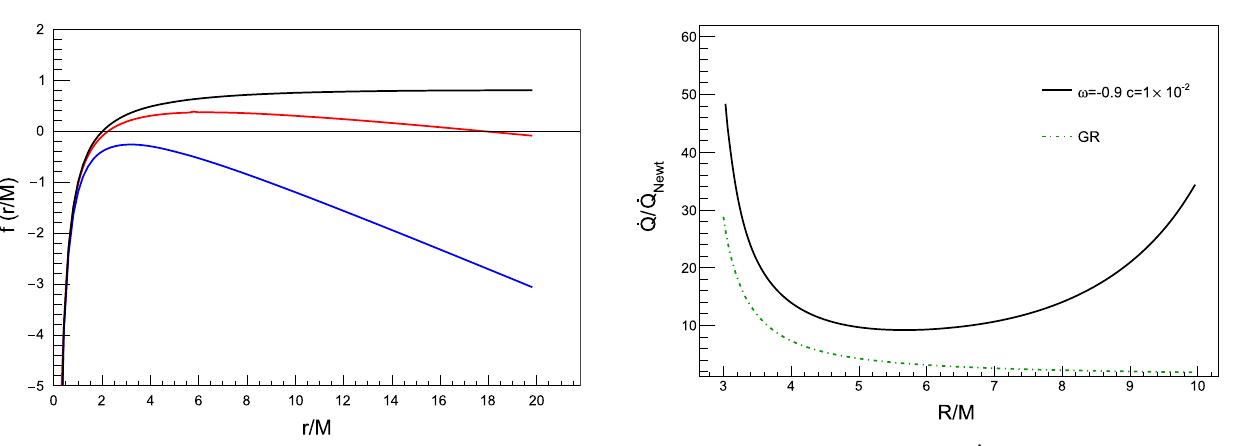
Fig. 1 The f ( r ) function defined in (2) vs r / M , The parameters ω q and c are fixed as ω q = − 2 / 3, c = 0 . 01 (black), c = 0 . 05 (red) and c = 0 . 2 (blue). As arises from the plot, increasing the values of the constant c , the curves approach the event horizon, corresponding to f ( r / M ) = 0, until the formation of a naked singularity (blue curve)